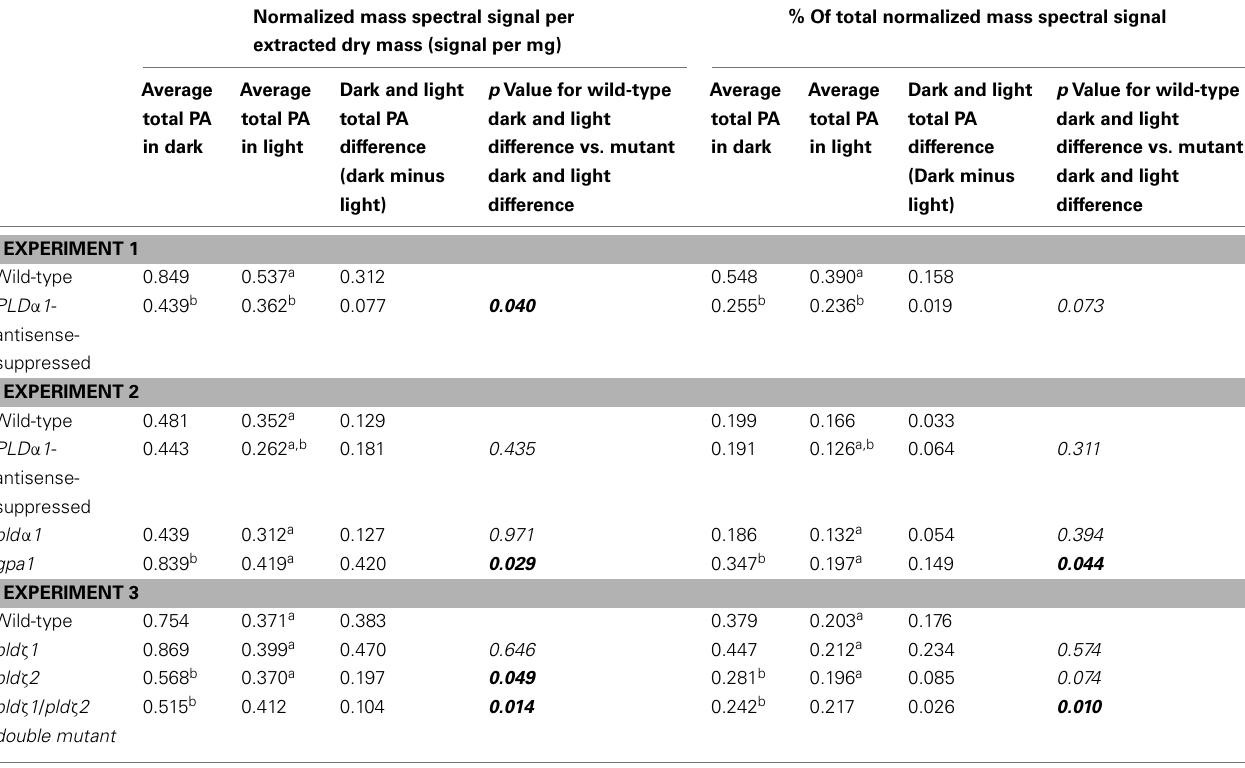
Table 3 | Comparison of differences in dark and light leaf total PA levels for wild-type plants vs. plants defective in selected phospholipase Ds or their